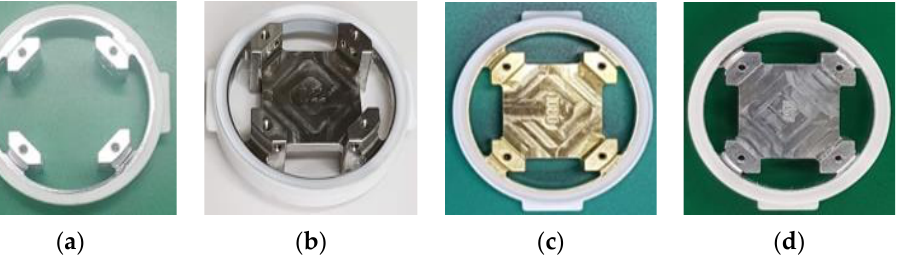
Figure 7. Improvement process of designed vibration isolator: ( a ) 4-point fixed isolator; ( b ) stainless steel integrated isolator; ( c ) brass integrated isolator; ( d ) aluminum integrated isolator.